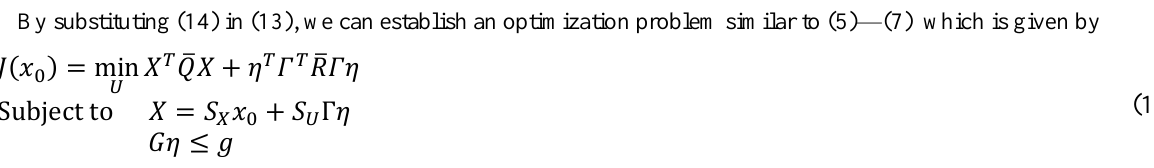
Figure 2. Output of Kautz network in time domain for different pairs of